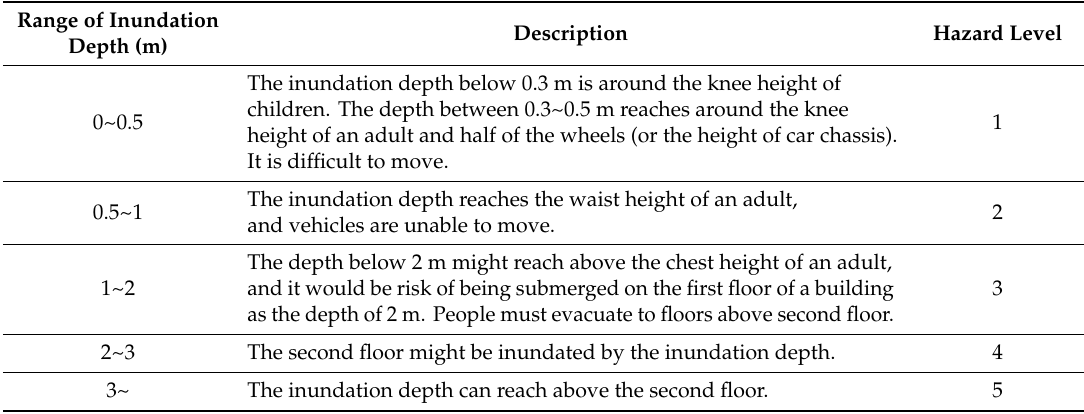
Table 2. The definition of hazard levels with di ff erent ranges of inundation